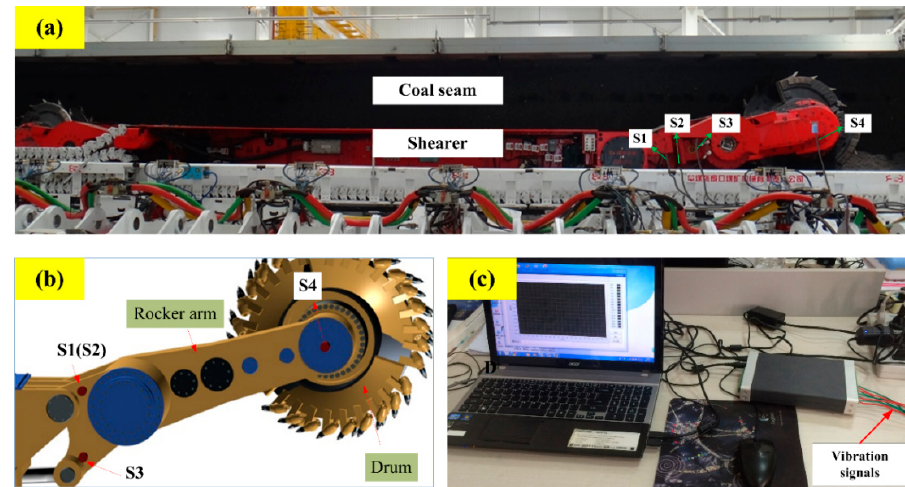
Figure 4. Self-designed experimental system for shearer cutting coal: ( a ) The experiment bench of shearer cutting coal; ( b ) The installation sketch of accelerometers; ( c ) Vibration signals processing device.